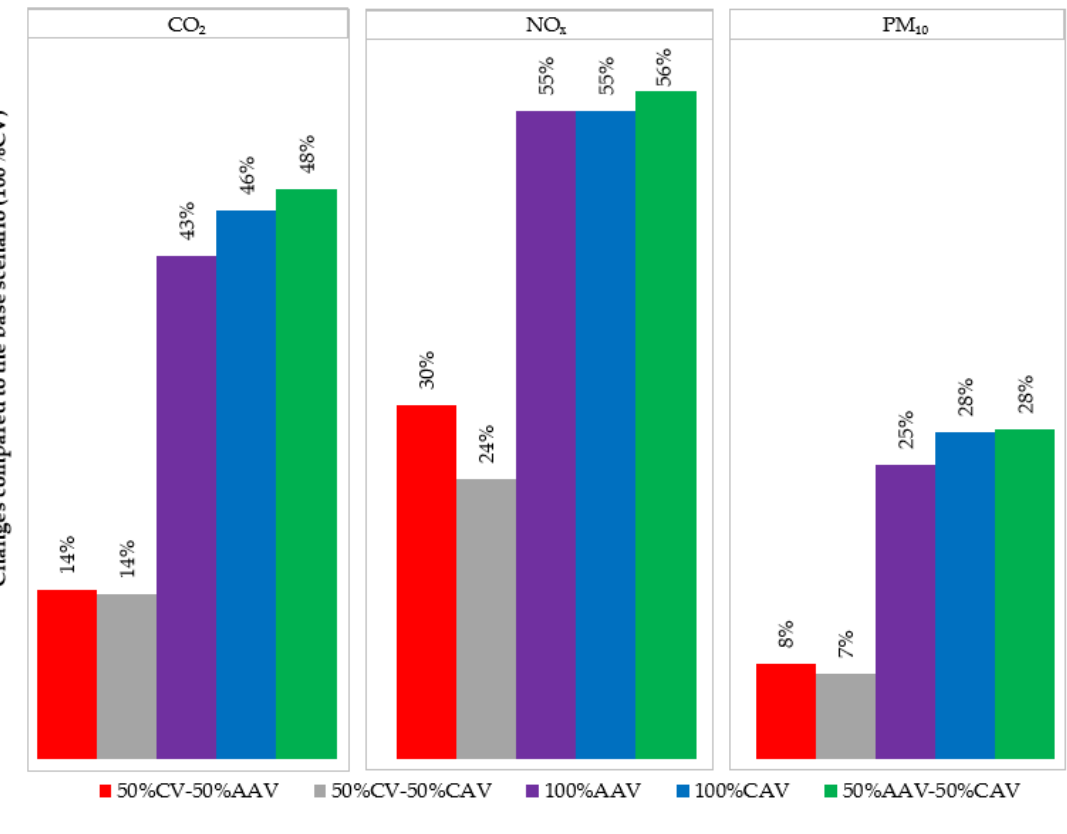
Figure 12. Simulation results of traffic emissions compared to the base scenario (100% CV): weaving segment.